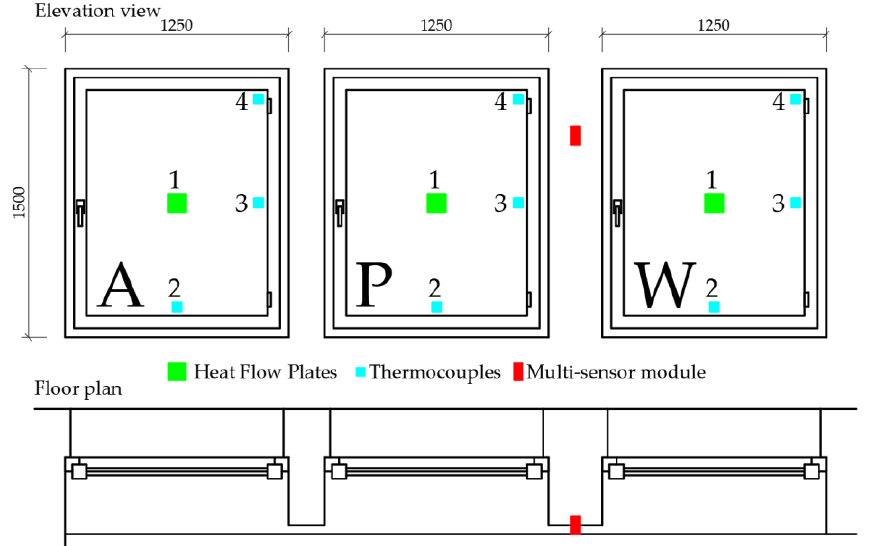
Figure 5. Location of monitoring devices.